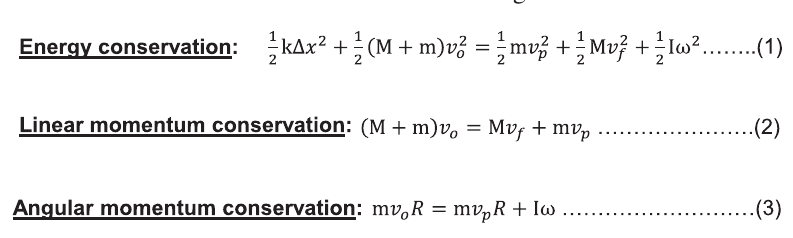
FIG. 10. The three essential equations for solving the simultaneous synthesis